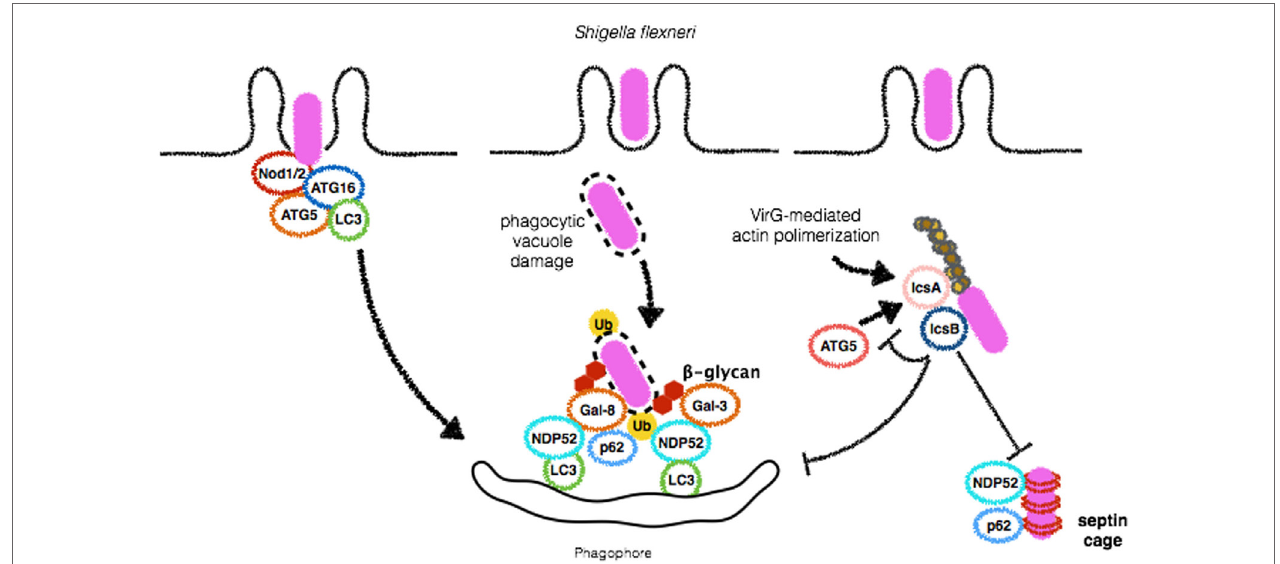
FigURe 3 | Shigella flexneri employs different mechanisms to escape from autophagy. During bacterial entry into host cells, Nod1 and Nod2 recruit ATG16L1 to initiate autophagosome formation in order to restrict S. flexneri replication (left). Vacuole damage leads to β -glycan exposure and recognition by Galectins 3 and 8 and recruitment of NDP52, followed by bacterial ubiquitination and binding to p62 and NDP52, culminating to S. flexneri targeting for autophagic degradation (center). IcsB plays a central role in disguising autophagic machinery. This protein competes with IcsA/VirG for binding to ATG5, preventing p62, and NDP52 binding, septin caging and autophagosome formation (right). Septin caging and further recruitment of autophagic adaptors are blocked by IcsB